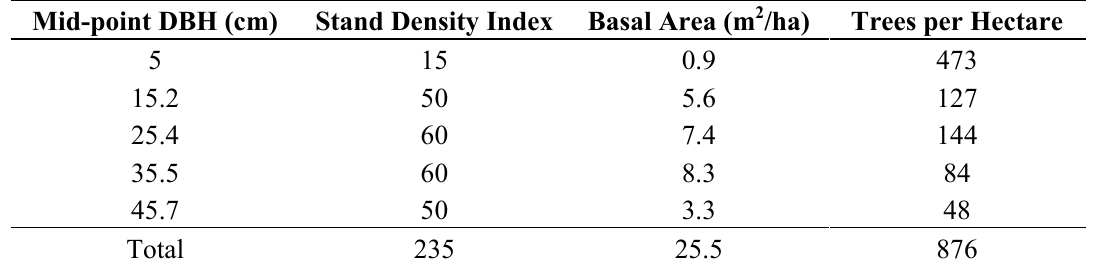
Table 1. Example: Uneven-aged stand attributes for low hazard